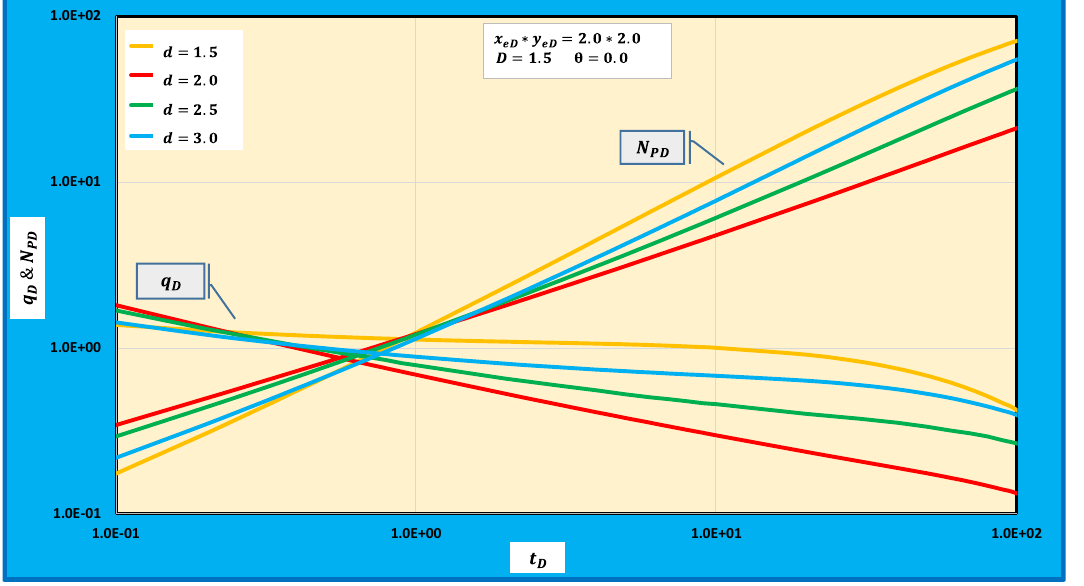
Fig. 25 Flow rate and cumulative production during the pseudo-radial flow regime for different fractal